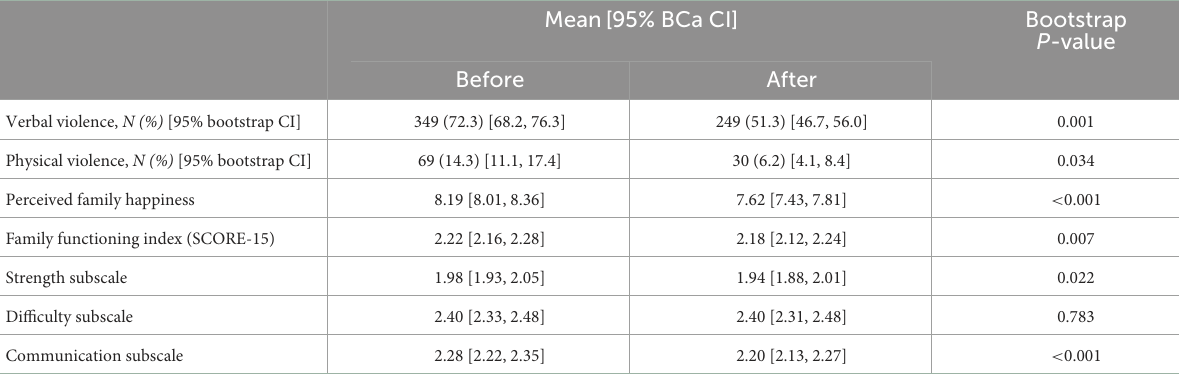
TABLE 2 Family atmosphere and family functioning before and after the COVID-19